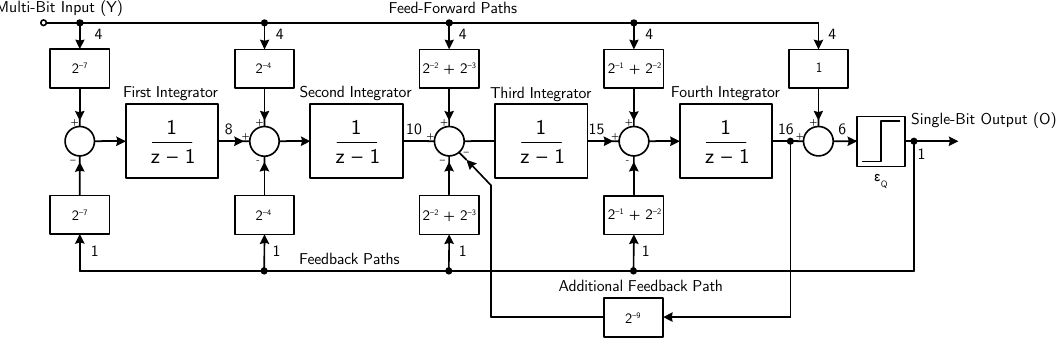
Figure 13. Block diagram of the fourth-order, digital ΣΔ modulator (example